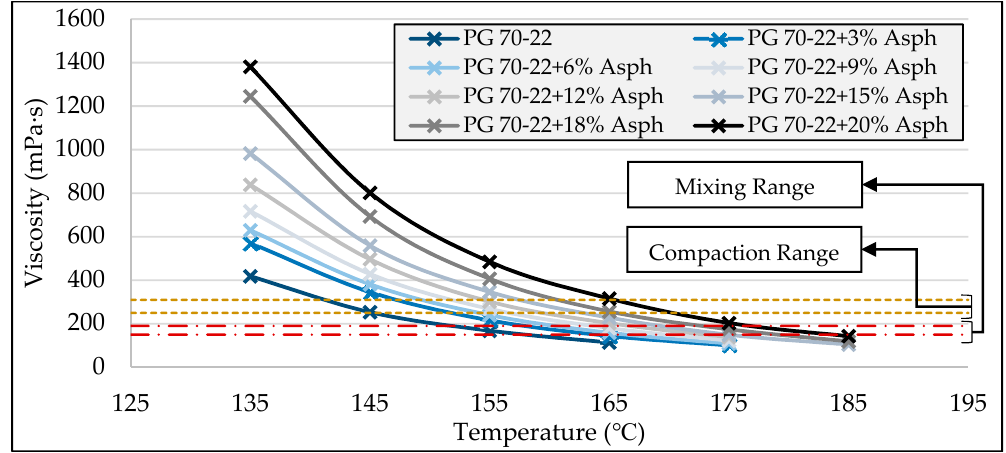
Figure 7. High-temperature viscosity of asphaltenes-modified binders versus temperature.